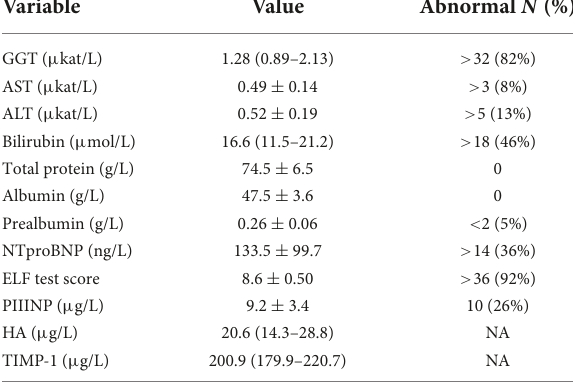
TABLE 2 Biochemical tests in 39 patients at the study.